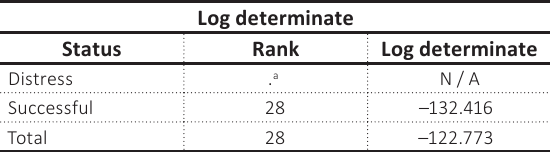
Table 4. Equality of covariance